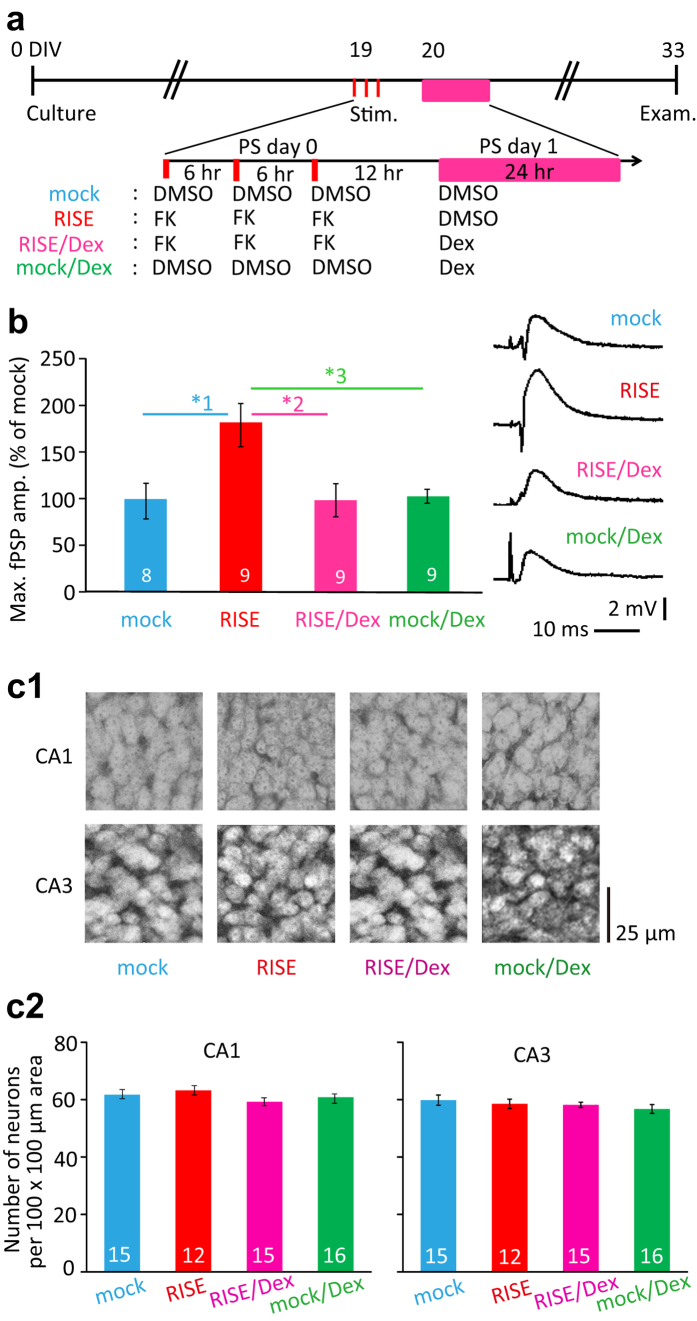
Suppression of RISE in cultured hippocampal slices by Dex, applied 12 hr after stimulation.(a) Experimental timeline for electrophysiological examination. Culture age was counted as the day of culture 0 DIV (days in vitro). At 19 DIV, FK (forskolin; 20 μM, 20 min) or DMSO (dimethylsulfoxide; vehicle for FK) was applied three times at 6 hr intervals. This day was reckoned as PS (post-stimulus) day 0. Dex (100 nM) was applied for 24 hr beginning 12 hr after the third application of FK (i.e. PS day 1). At PS day 14 (i.e. 33 DIV), electrophysiological examinations were performed. (b) Maximal fPSP amplitude taken as a functional index for RISE. As explained in Methods section, the control (mock) and experimental samples were subjected to fPSP measurements on the same day using a single lot of culture. The mean value of control samples was taken as 100% for each lot. In this and following figures, the numeral placed in each bar of the graph indicates the number of samples constructing the data shown. The same measurement was repeated 4 times using 4 lots of culture (i.e. 4 dams). Absolute P values are 2.15E-2 for *1, 1.50E-2 for *2, 2.42E-2 for *3. (c) Absence of cytotoxic effect of Dex. Representative fluoromicrographs are shown in c1 and pooled data are shown in c2. The numbers of NeuN-immunopositive nuclei were enumerated for ~50 × ~50 μm areas of the CA1 and CA3 pyramidal layers at PS day 14 and shown after conversion to 100 × 100 μm areas. The same measurement was repeated 4 times using 4 lots of culture (i.e. 4 dams).